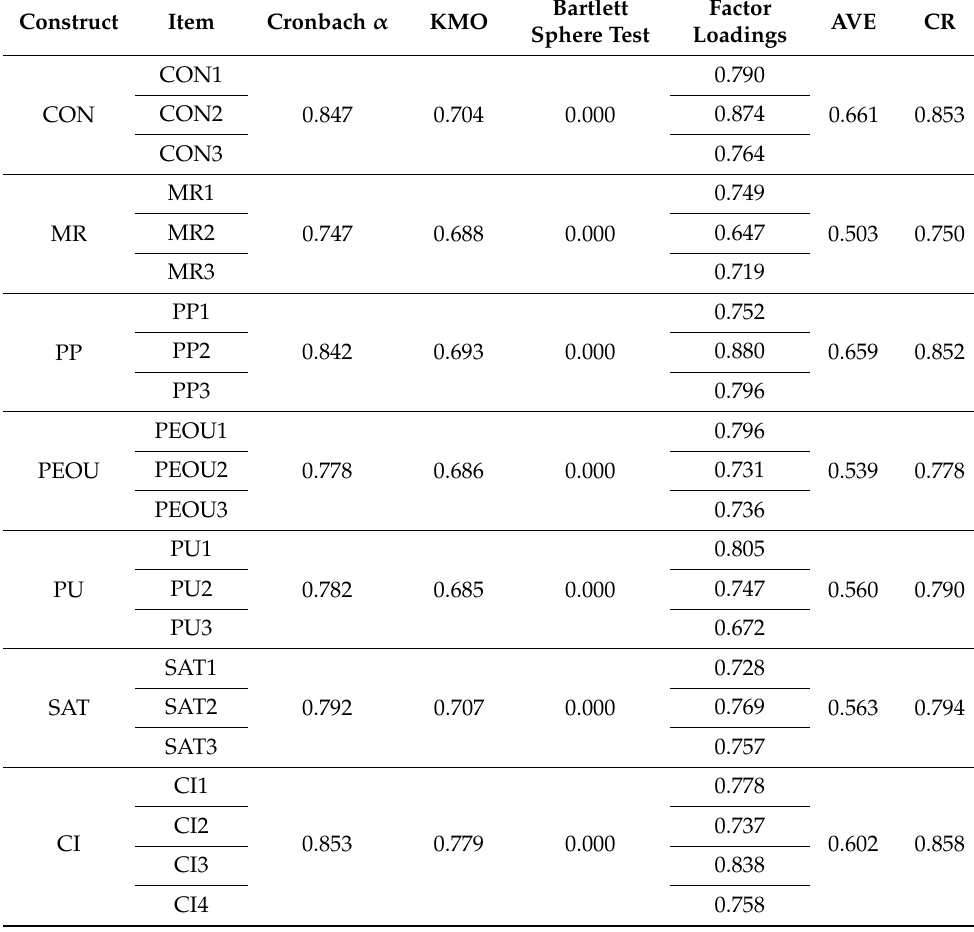
Table 2. Reliability and convergent